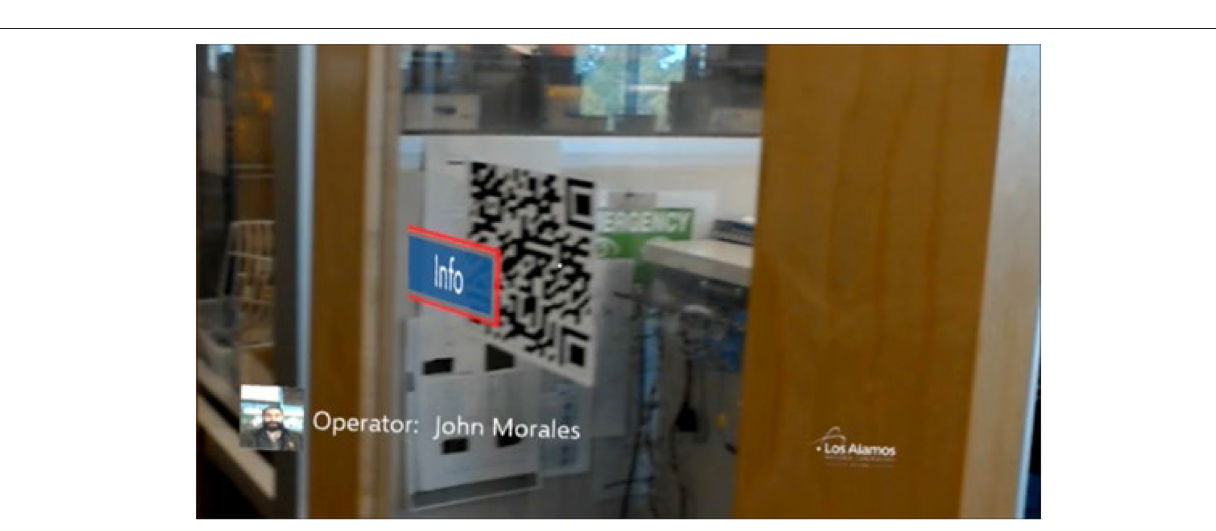
FIGURE 12 | The doors of the mock facility have been instrumented with QR codes. The augmented reality headset can recognize the QR codes. A holographic interface can provide information to the operator regarding the contents of the room if they air-tap the info. the canister. The glovebox demonstration setup can be